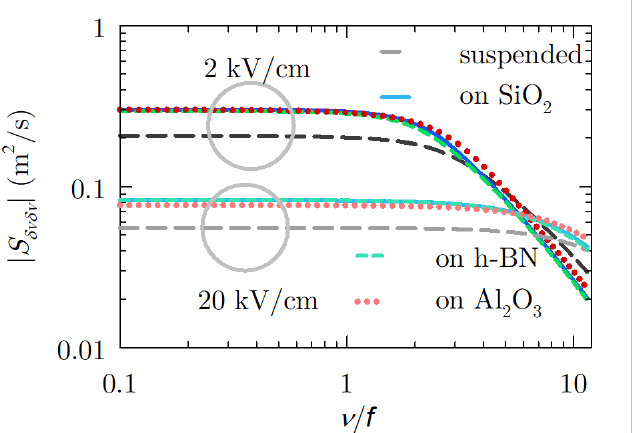
Figure 6. Noise spectrum of velocity fluctuations as a function of the frequency normalised to that of the AC field for all the considered cases with E AC = 2 and 20